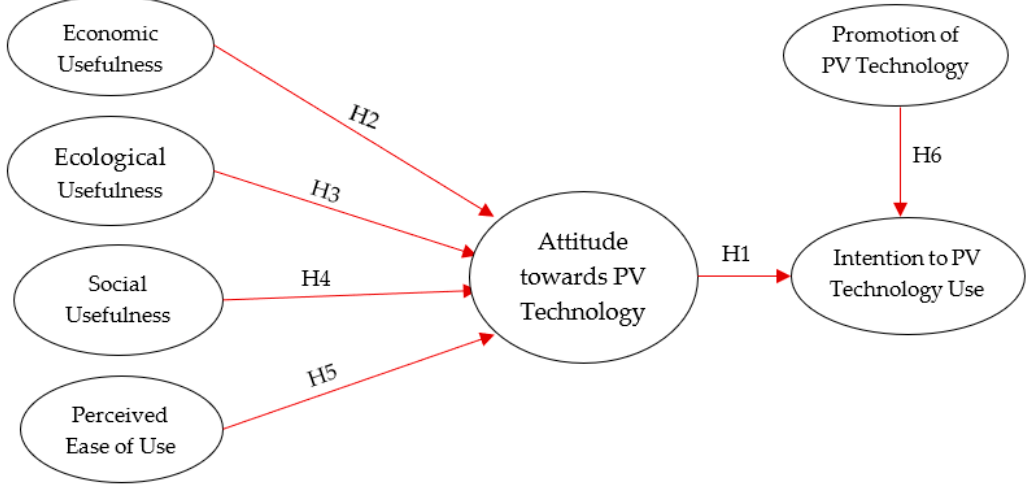
Figure 1. Test model. Source: own work.